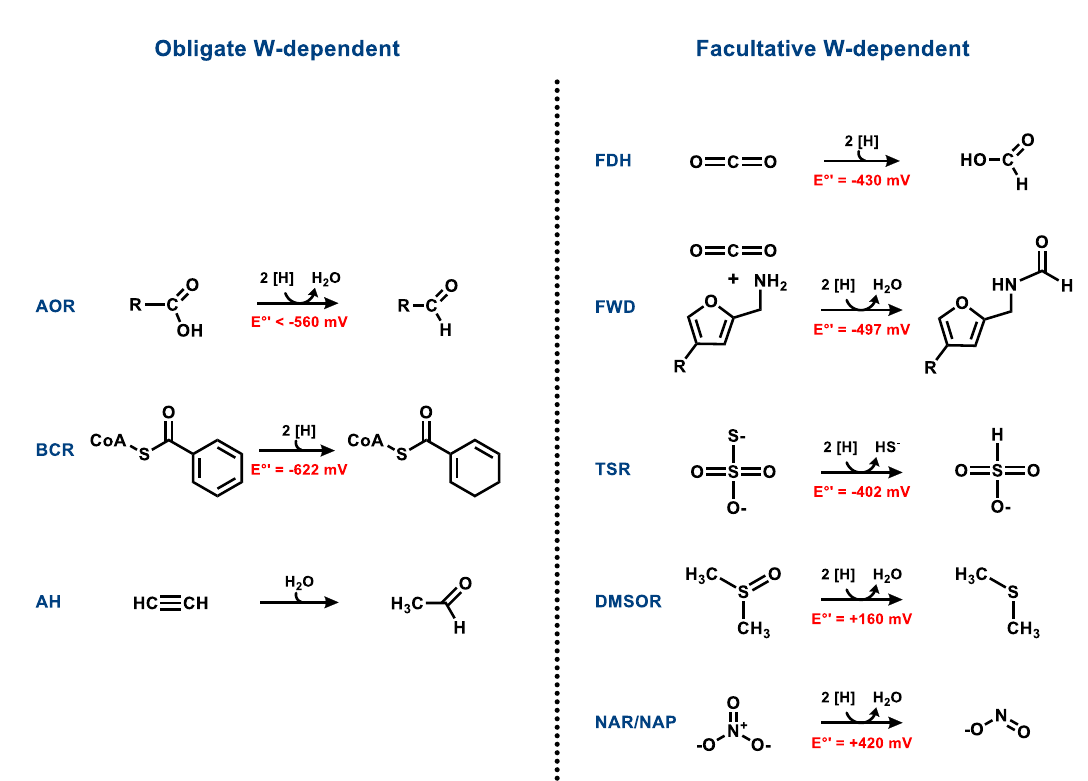
Figure 2. Reactions catalyzed by obligately and facultatively tungsten-dependent enzymes.